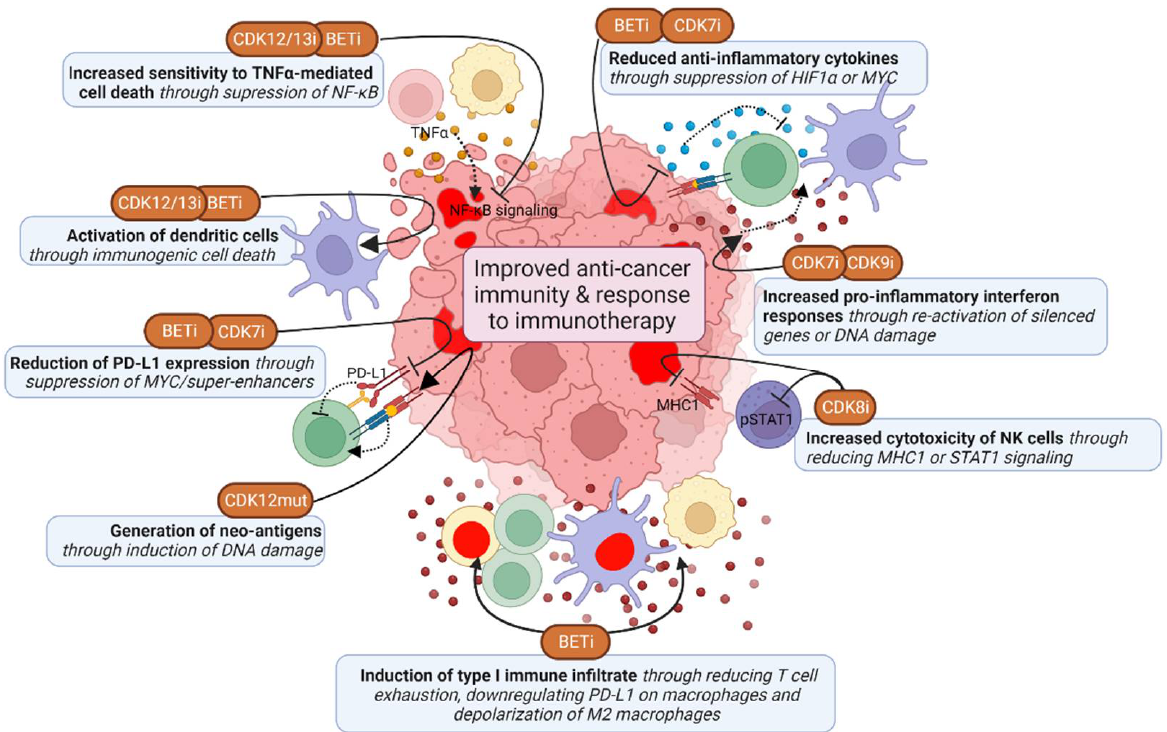
Figure 5. Effects of TMi’s on anti-cancer immunity. TMi’s improve anti-cancer immunity by sup- pressing expression of anti-inflammatory cytokines and PD-L1 in cancer cells, but also in immune cells directly, thereby inducing inflammatory type 1 immune responses. TMi’s also induce pro- inflammatory IFN-y responses in cancer cells, induce sensitivity to TNF α -mediated cell death and induce immunogenic cell death. CDK8 inhibition mostly improves anti-cancer immunity by enhanc- ing natural killer (NK) cell cytotoxicity. This figure was created with BioRender.com (accessed on 8 August 2022).